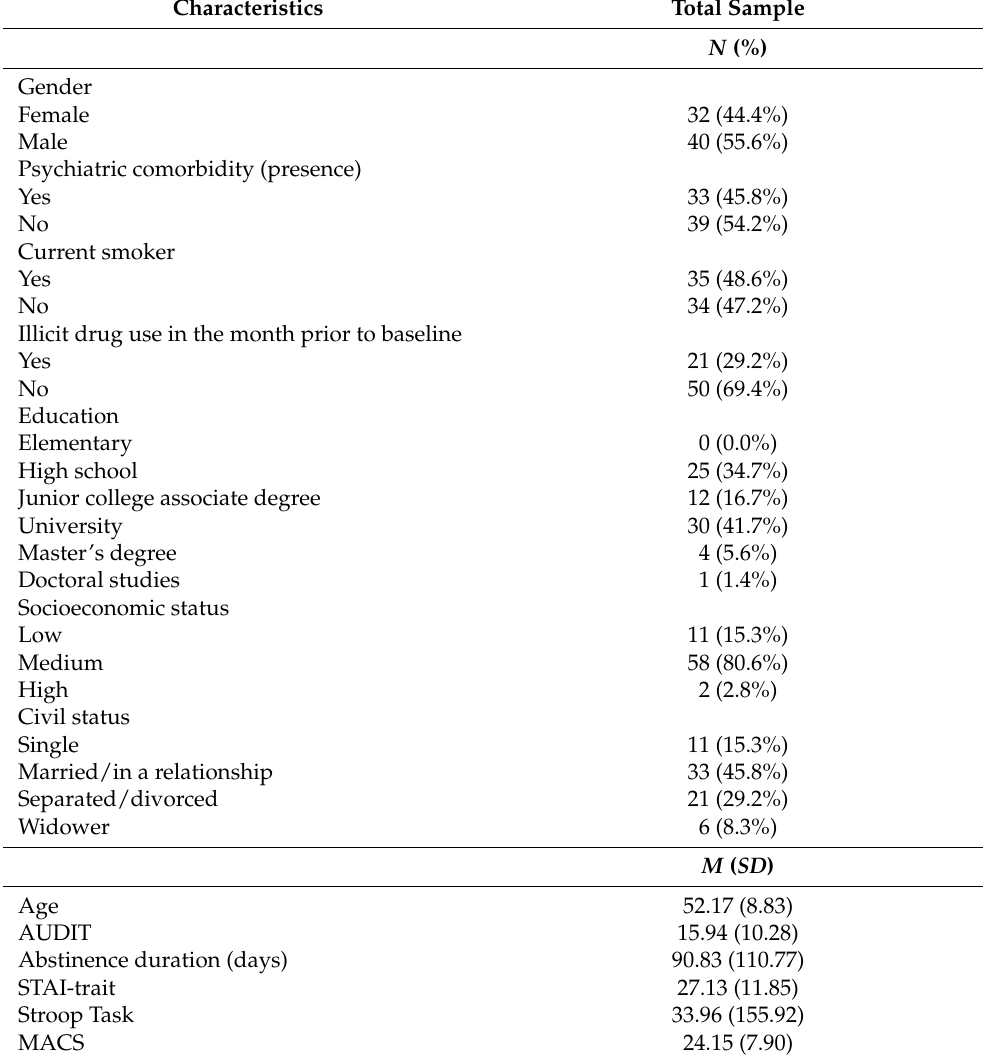
Table 1. Participant characteristics at baseline ( n =